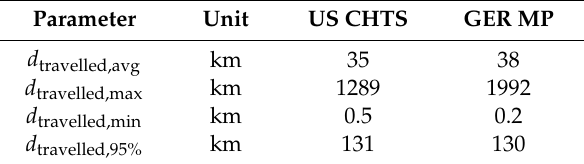
Table 2. Mean, maximum, minimum and 95%-ile of distance traveled since last departure from home. Parameter Unit US CHTS GER MP d travelled,avg km 35 38 d travelled,max km 1289 1992 d travelled,min km 0.5 0.2 d travelled,95%